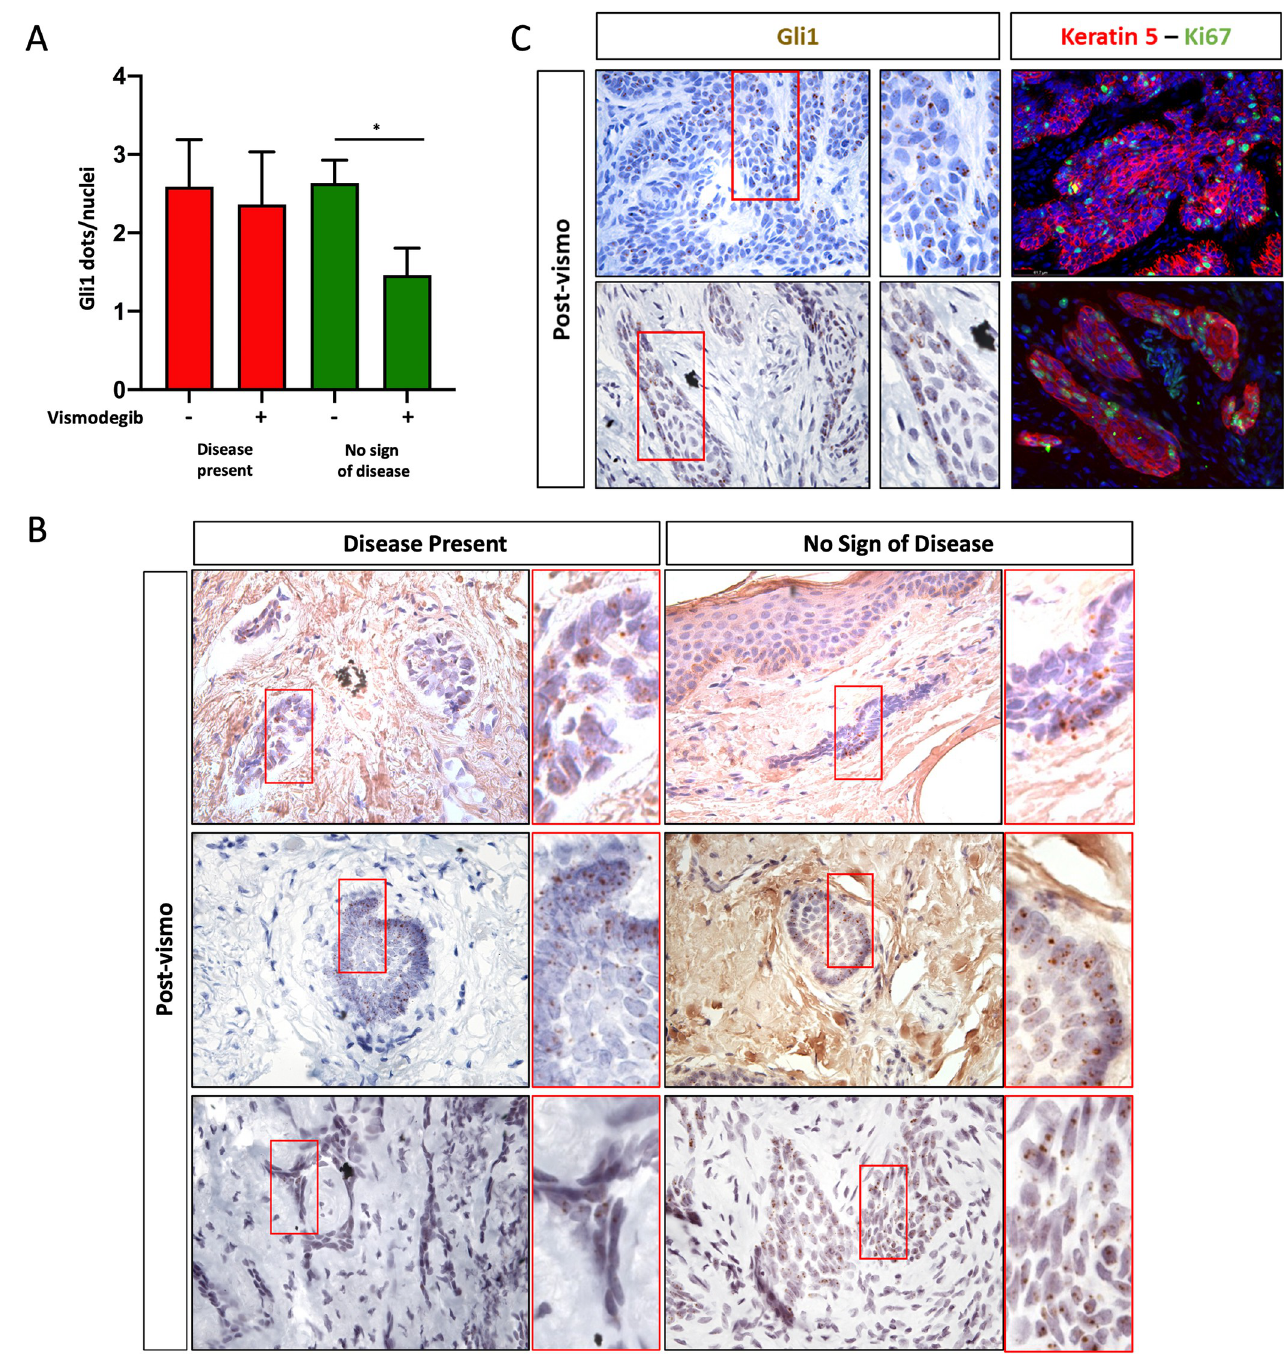
Fig 2. Persistent BCC expresses Gli1 and is proliferative. A) Gli1 expression (dots/nuclei) pre- and post-vismodegib treatment in patient samples scored as disease present (red) or no sign of disease (green) (error bars indicate SEM, unpaired t-test � p < 0.05, n = 7,6,9,11 columns left to right), B) Gli1 expression (brown dots) in excision samples from “disease present” (left panels) and “no sign of disease” (right panels) samples. C) Gli1 expression (left panels, brown) and proliferation (Ki67, green) in keratin 5 positive (red) persistent lesions from samples scored as disease present (top panels) and no sign of disease (bottom